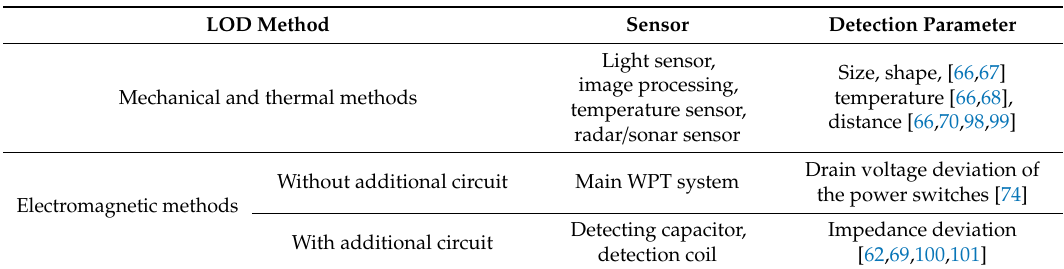
Table 2. Living object detection (LOD)